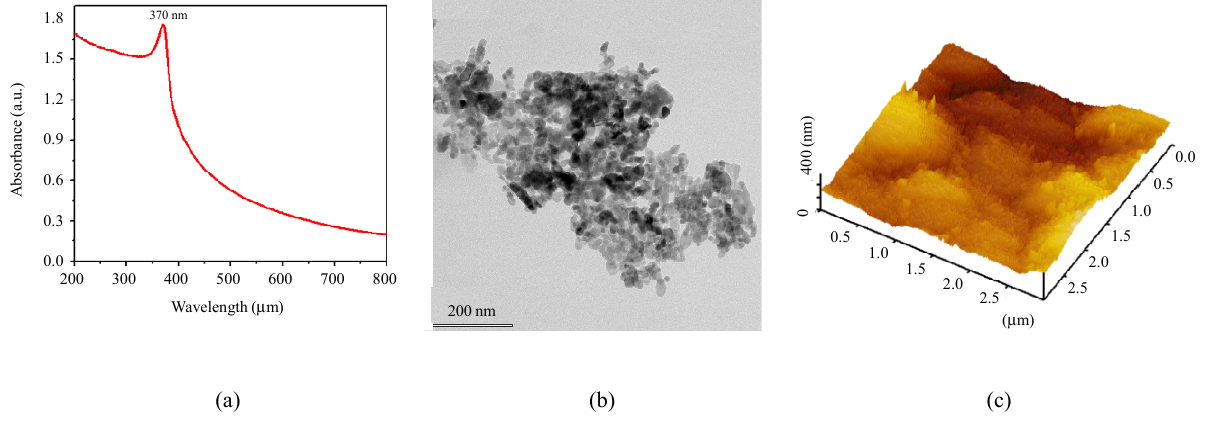
Fig. 9 Characterizations of zinc oxide nanoparticles: (a) absorbance spectrum, (b) TEM image, and (c) AFM